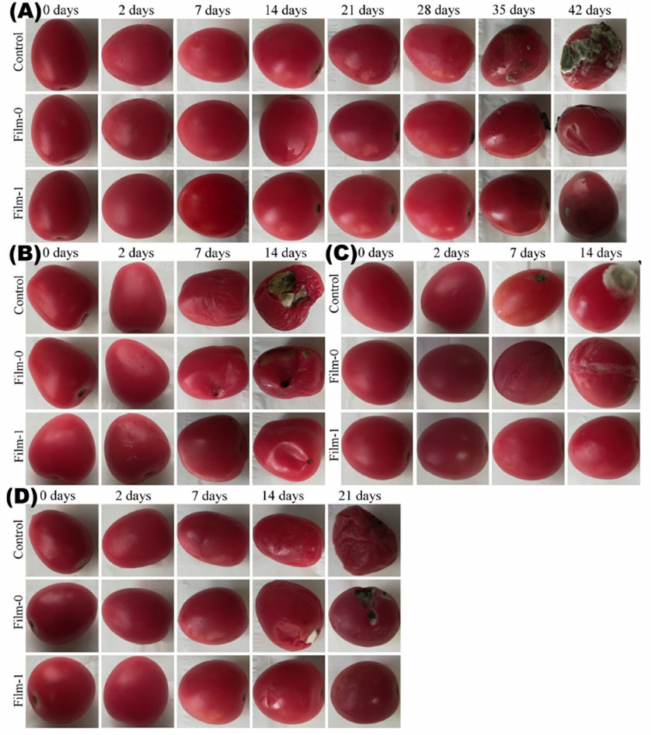
Figure 10. The photographs of uncoated tomatoes (control), BC-coated tomatoes (Film-0), and BC/CMC/Gly/yeast-coated tomatoes (Film-1) stored at ( A ) 6 ◦ C, ( B ) 40 ◦ C, ( C ) 30 ◦ C, and ( D ) room temperature (20 to 25 ◦ C) for different time intervals.